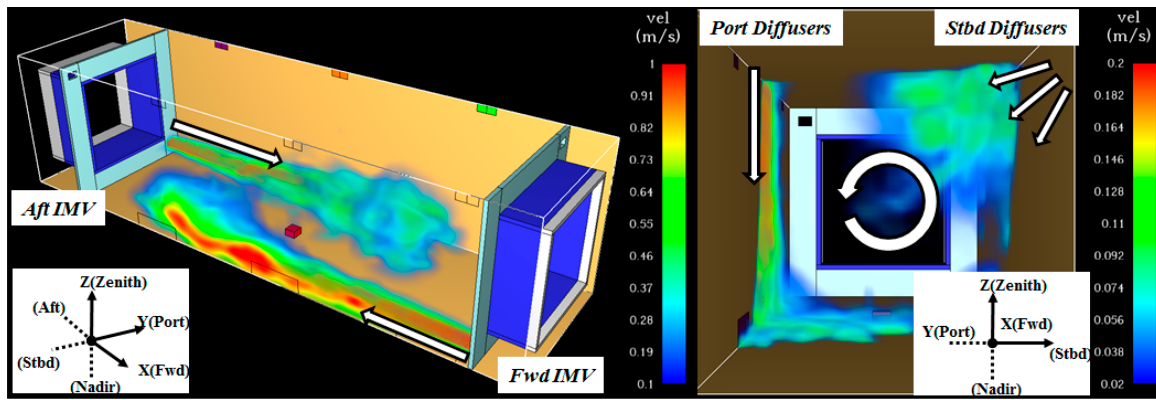
Figure 5. Ventilation flow inside ISS Destiny module numerically analyzed using FDS.